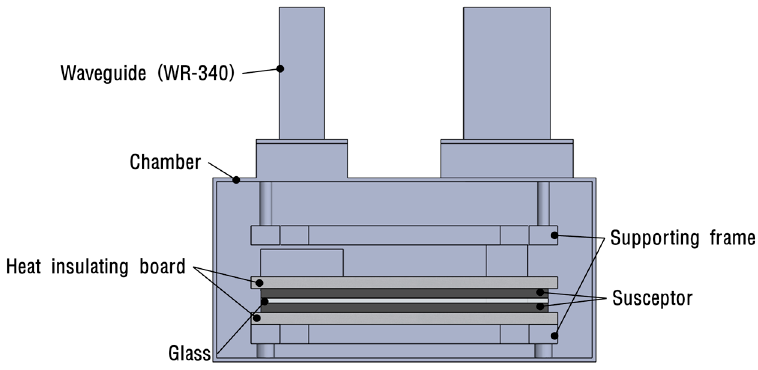
Figure 4. Glass-heating system setup with a graphite susceptor.